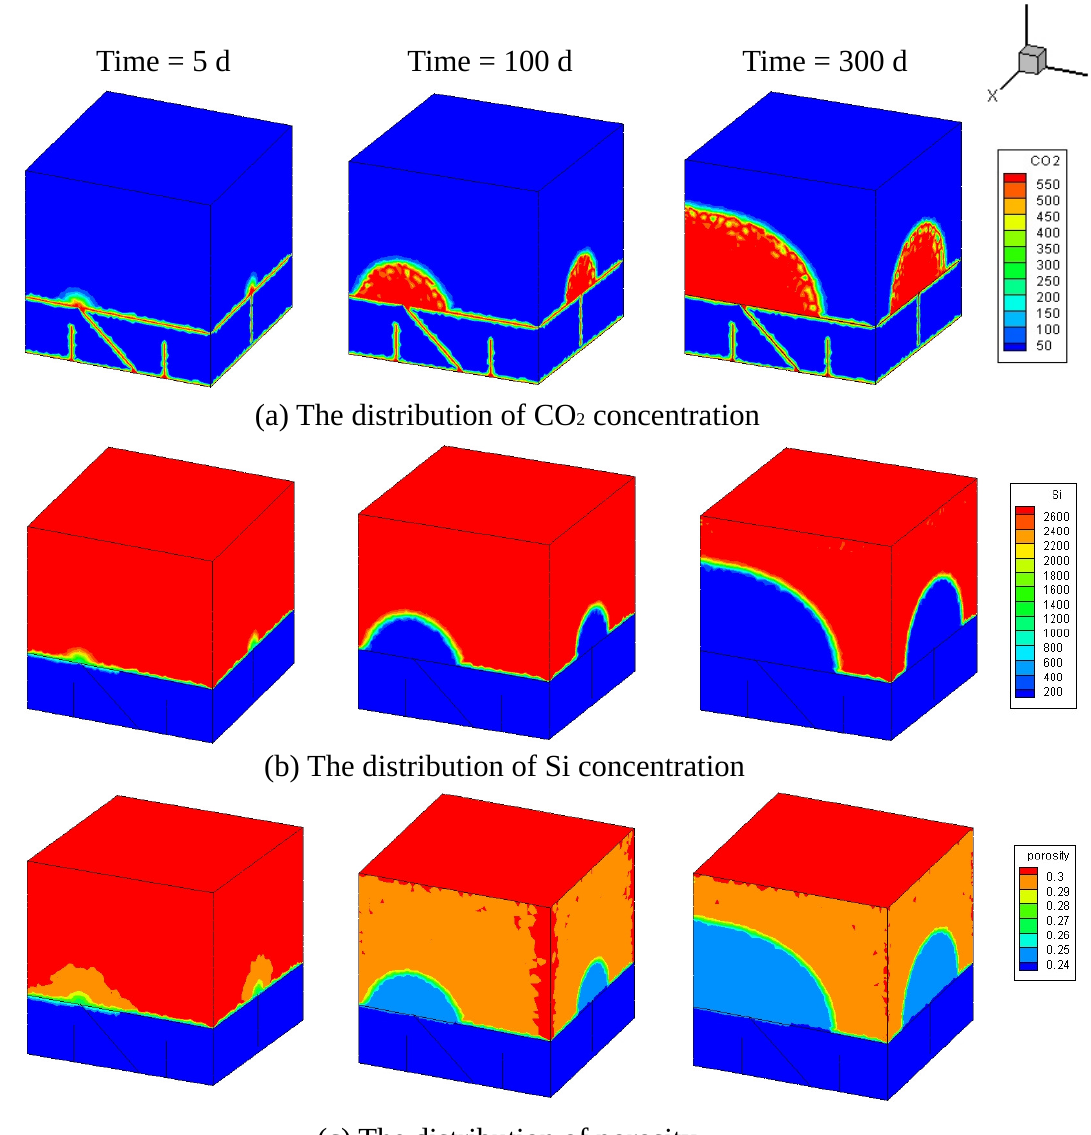
Figure 10. Numerical results of CO 2 sequestration at Si concentration of 3000 mol/m 3